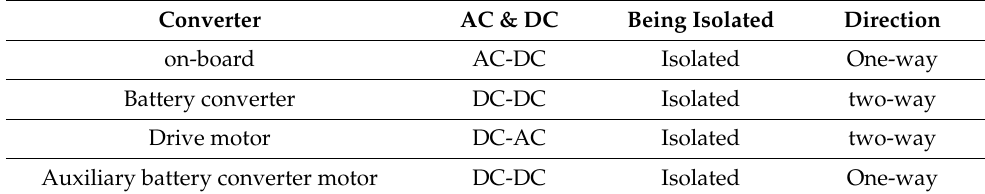
Table 5. Checking isolation, direction and AC, DC power converters of